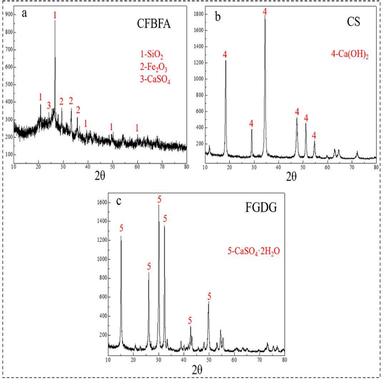
XRD of raw materials (a:XRD of CFBFA, b: XRD of CS, c: XRD of FGDG).